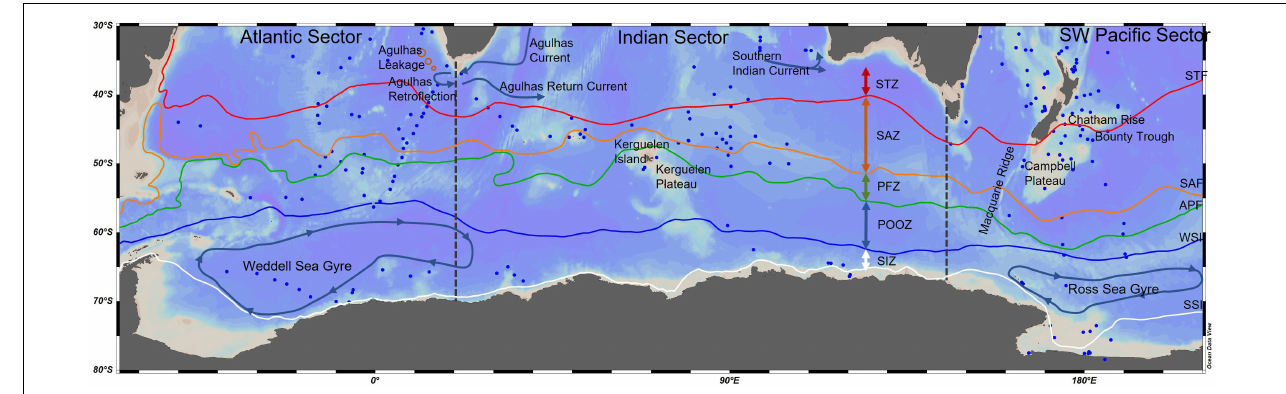
FIGURE 1 | Southern Ocean map showing the location of surface sediment sites of the SO-RAD database (Lawler et al., 2021) south of 30 ◦ S within each sector of the Southern Ocean. Major topographical and hydrological features discussed in this paper and the division between three Sectors – Atlantic, Indian and Southwest Pacific. Hydrological fronts [STF (red), Subtropical Front; SAF (orange), Subantarctic Front; APF (green), Antarctic Polar Front; Orsi et al., 1995] and zones (STZ, Subtropical Zone; SAZ Subantarctic Zone; PFZ, Polar Frontal Zone; POOZ, Permanently Open Ocean Zone; SIZ, Seasonal Sea-Ice Zone), summer and winter sea-ice margins [WSI (blue), Winter Sea-Ice Margin; SSI (white), Summer Sea-Ice Margin], major Eastern Boundary Currents and the two major gyres – Weddell Sea and Ross Sea Gyres. Blue arrows depict regional currents and gyres, and direction of flow.